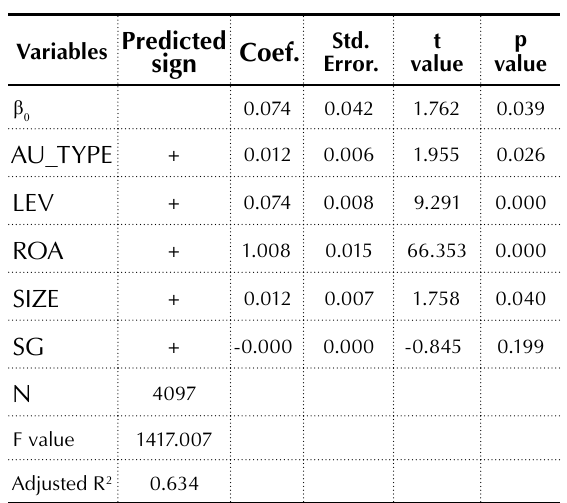
Table 5. Earnings conservatism and organization type: Accrual based